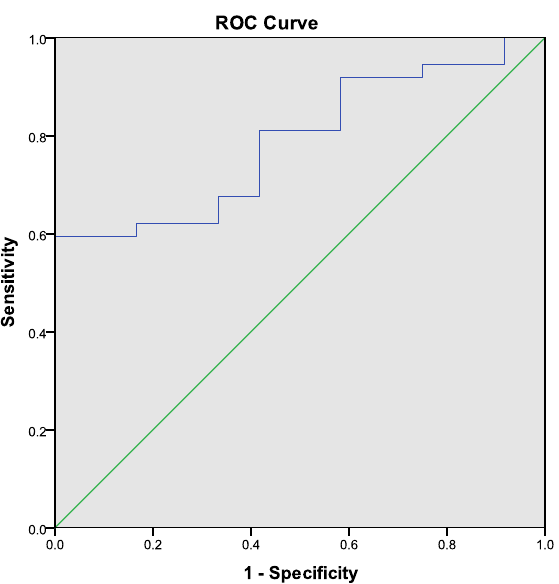
Figure 4. ROC analysis of combined T1 mean and T2 mean to screen cardiac involvement from IIM patients (AUC = 0.788, p =